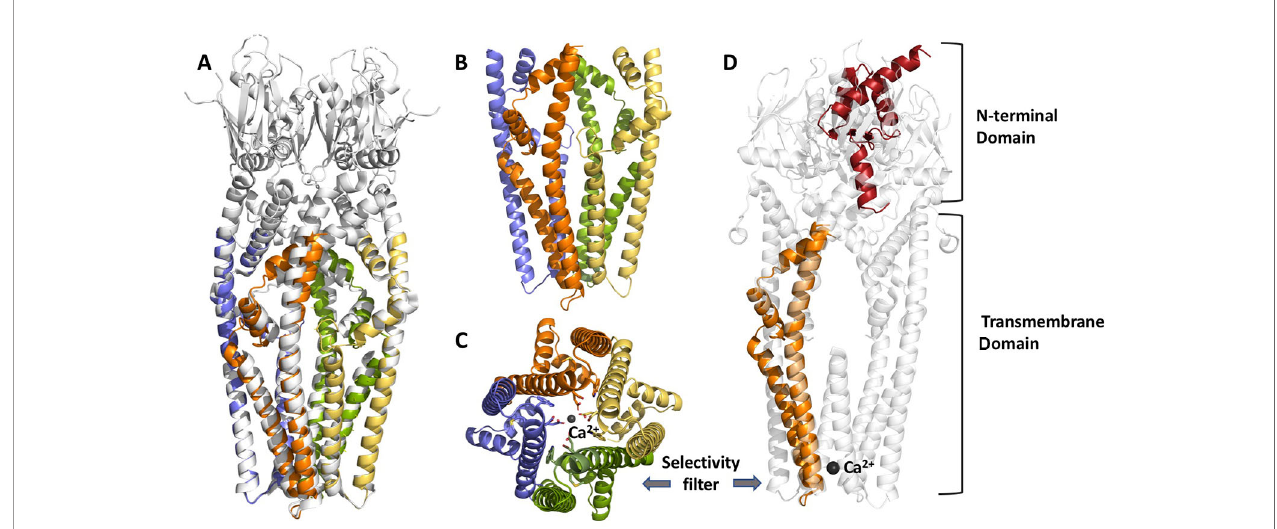
FIGURE 1 | Structural features of chloroplast MCU from Arabidopsis thaliana , modelled by Phyre V 2.0. From the left to the right: (panel A ) cartoon view of the superposition of MCU structure from Neurospora crassa (cryoEM, 3.7 Å resolution, PDB:6DT0, grey), used as a reference, and predicted A. thaliana cMCU transmembrane tetrameric assembly (coloured chains); (panel B, C ) details of the transmembrane (TM) and coiled-coil domain (CCD) tetrameric assembly and selectivity fi lter (panel C ), where the four chains are shown in yellow, orange, pale violet and green. The key acidic residues within the highly conserved motif (WDXXEP, where X is any hydrophobic residue) of cMCU are highlighted in sticks, as well as the coordinated calcium ion, shown as dark grey sphere; (panel D ) superposition of the model of one monomer of A. thaliana cMCU channel (orange and red) and N. crassa MCU tetramers (light grey); cMCU model shown here includes the transmembrane domain (TM), part of the coil-coiled region and the N-terminal domain (NTD), the last predicted according to our previous homology searches and its similarity toward Dictyostelium discoideum NTD (PDB:5Z2H, doi: https:/doi.org/10.1101/848002). The superposition underlines the divergence from metazoan NTDs and other structure-known fungal homologues such as NcMCU, CeMCU, MaMCU, and